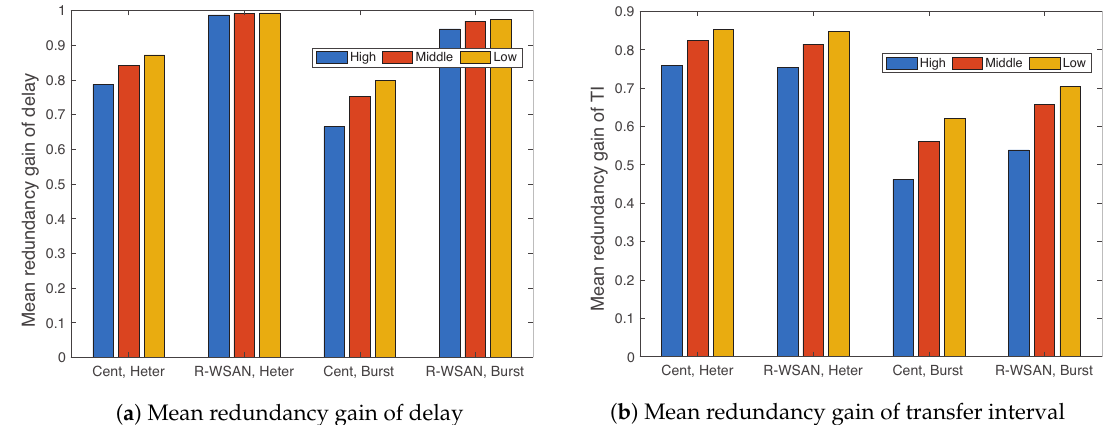
Figure 16. Mean redundancy gain of delay and transfer interval of three classes using R-WSAN and the centralized protocol with different heterogeneous and burst links. R-WSAN provides the robust delay and transfer interval performance for heterogeneous control